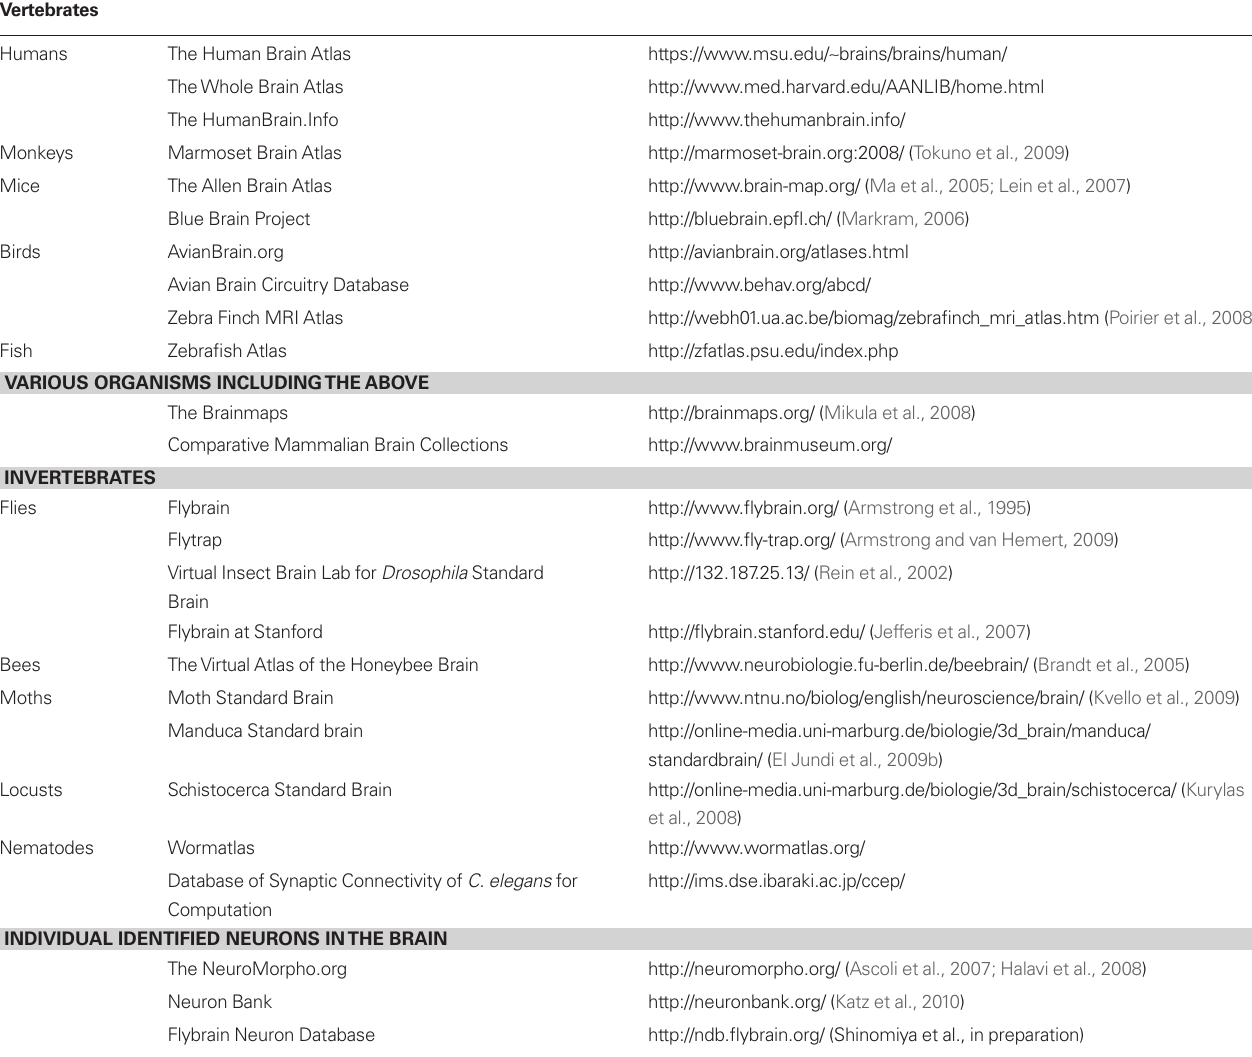
Table 1 | Examples of web-based digital atlases. Vertebrates